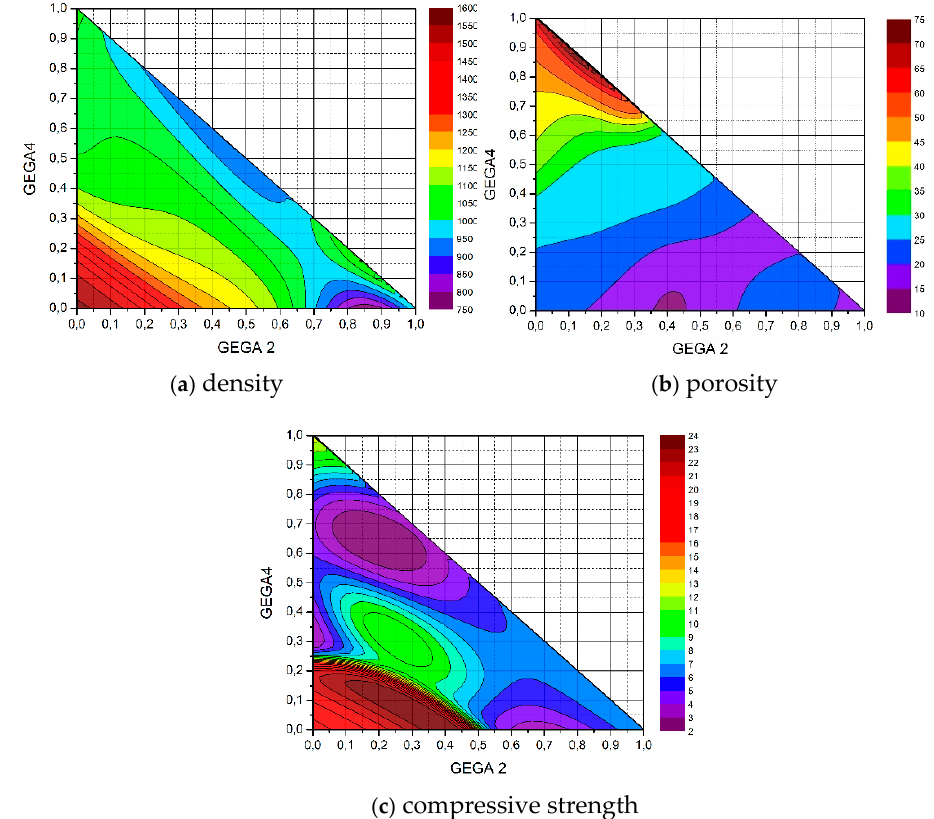
Figure 5. Projections of 3D charts on the plane of the shares of GEGA 2 mm and GEGA 4 mm in a specimen of LWC. Results, generated by ANN (prediction) ( a ) for density, ( b ) for porosity, ( c ) for compressive strength. The charts enable the choice of shares of individual aggregates in the concrete to optimize a few criteria, e.g., the lightest weight concrete of maximum strength.